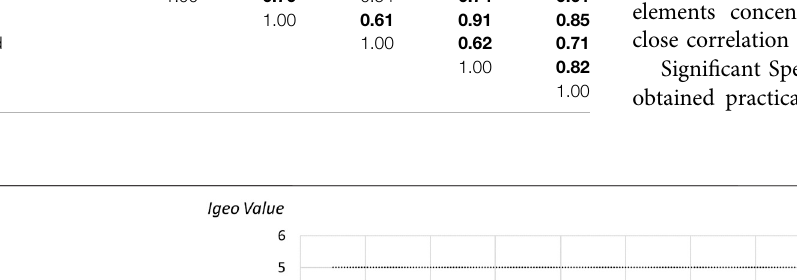
TABLE 5 | Spearman Rank Order Correlations (r) between concentrations of potentially toxic elements (Bolded correlations are signi fi cant at p < 0.05). Cu Pb Zn Cd Ni Cr Cu